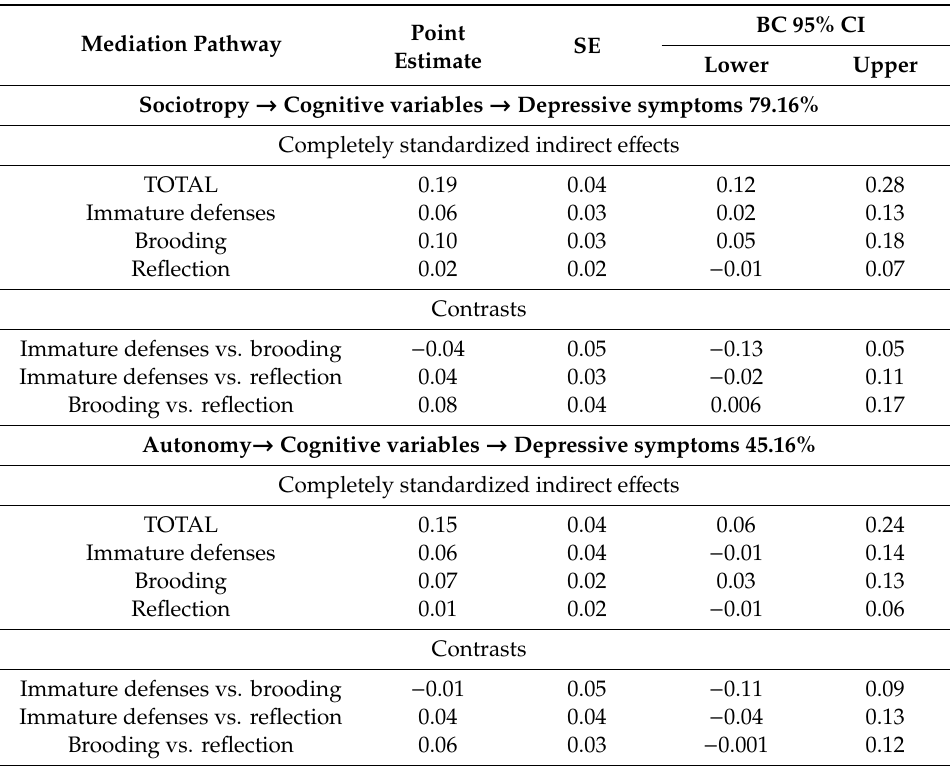
Table 3. Results of multiple mediation analysis of the relation between sociotropy and autonomy, respectively, and depressive symptoms in patients with GAD ( n =